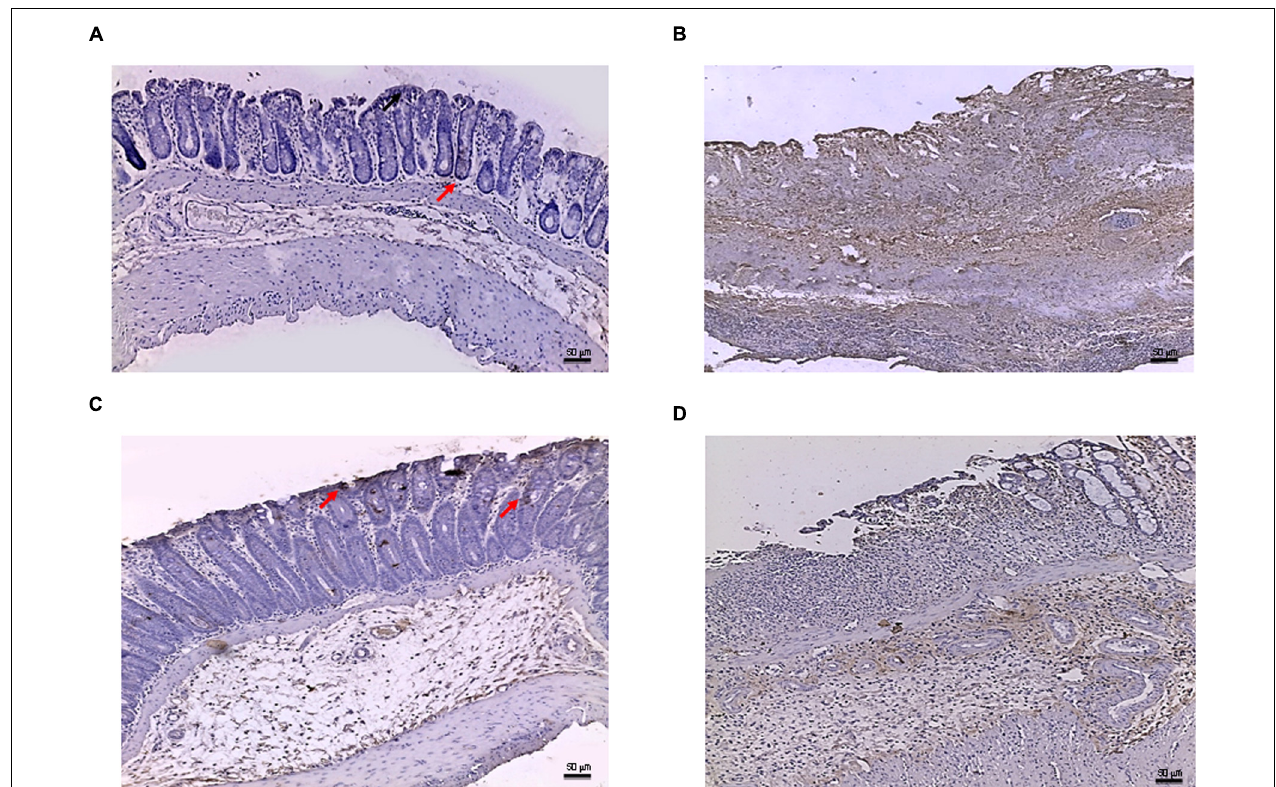
FIGURE 7 | Bax immunostaining from DSS-treated animals. Representative Bax immunostaining (original magnification 10 × ) of colons derived from control (A) , DSS + drug vehicle (B) , DSS + PDRN (C) , or DSS + PDRN + DMPX (D) treated animals are shown. The arrows in (A,C) point to regions of slight positivity. The pictures in (B,D) demonstrate a diffuse staining for the apoptotic factor. Scale bar 50 µ